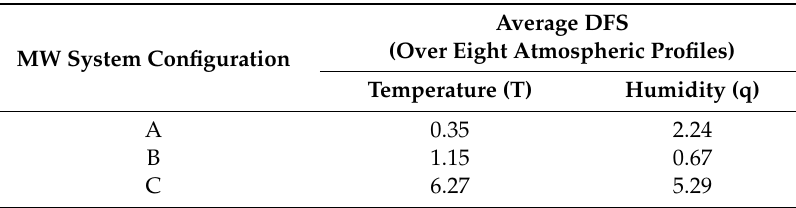
Table 3. Information Content (DFS) Estimations.